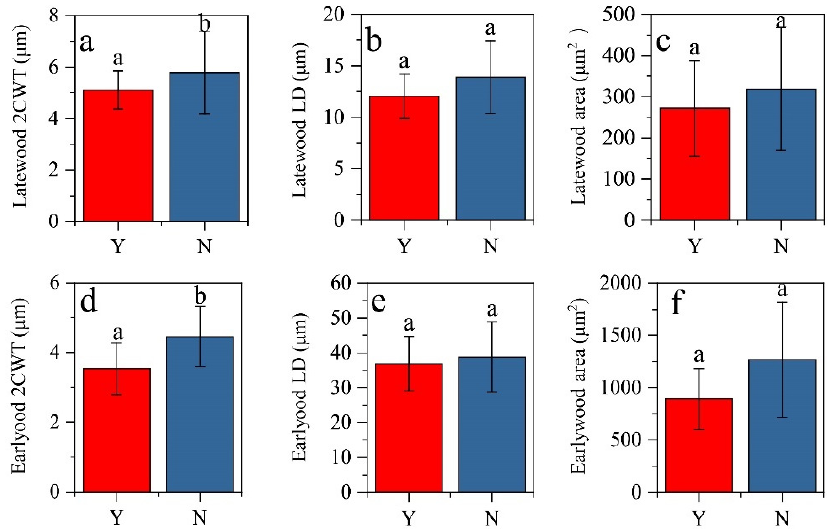
Figure 5. Comparison of the wood anatomy parameters (double cell wall thickness (2CWT) and radial lumen diameter (LD) and lumen area (LA) of latewood ( a – d ) and earlywood ( e , f ) between heat-protecting (Y) and without treatment (N). a, b—different letters indicate significant differences. Values are mean ± standard error (sample size n = 8).